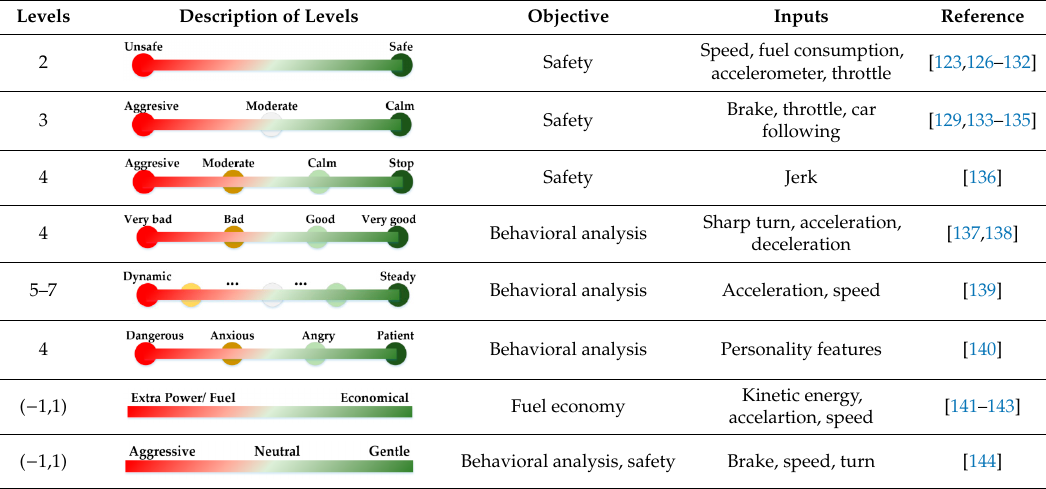
Table 2. A survey of work related to driving style recognition.